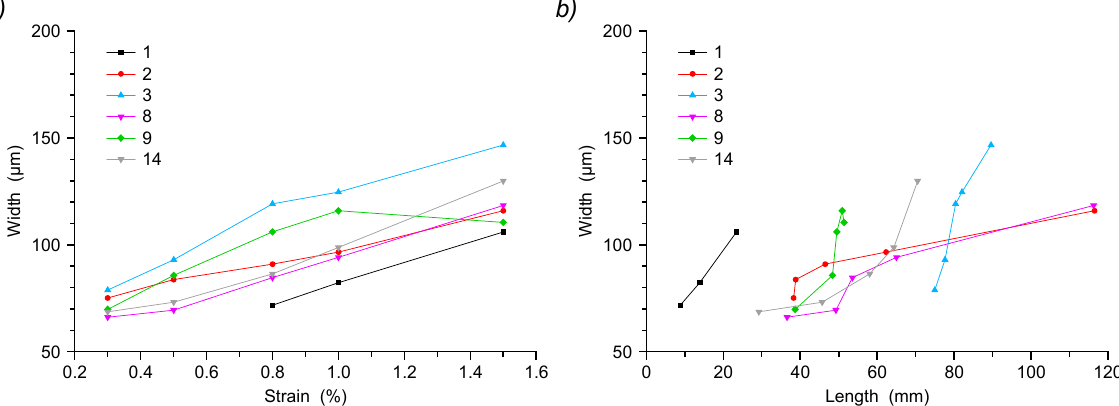
Figure 17. Crack width vs. sample strain ( a ) and crack width vs. length ( b ) for selected cracks in the sample shown in Figures 4 and 15. Width and length values are derived from the pixel values using the image reproduction scale. Points in each set of ( b ) correspond to different steps in strain progression (from 0.3% to 1.5%). Crack labels as depicted in Figure 4f.